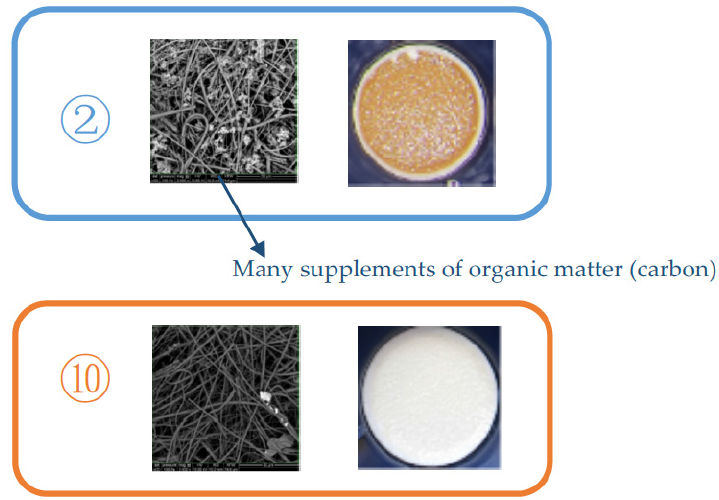
Figure 3. Filtration membranes and electron micrographs of hot water from the guest room faucets on site ② and ⑩ .